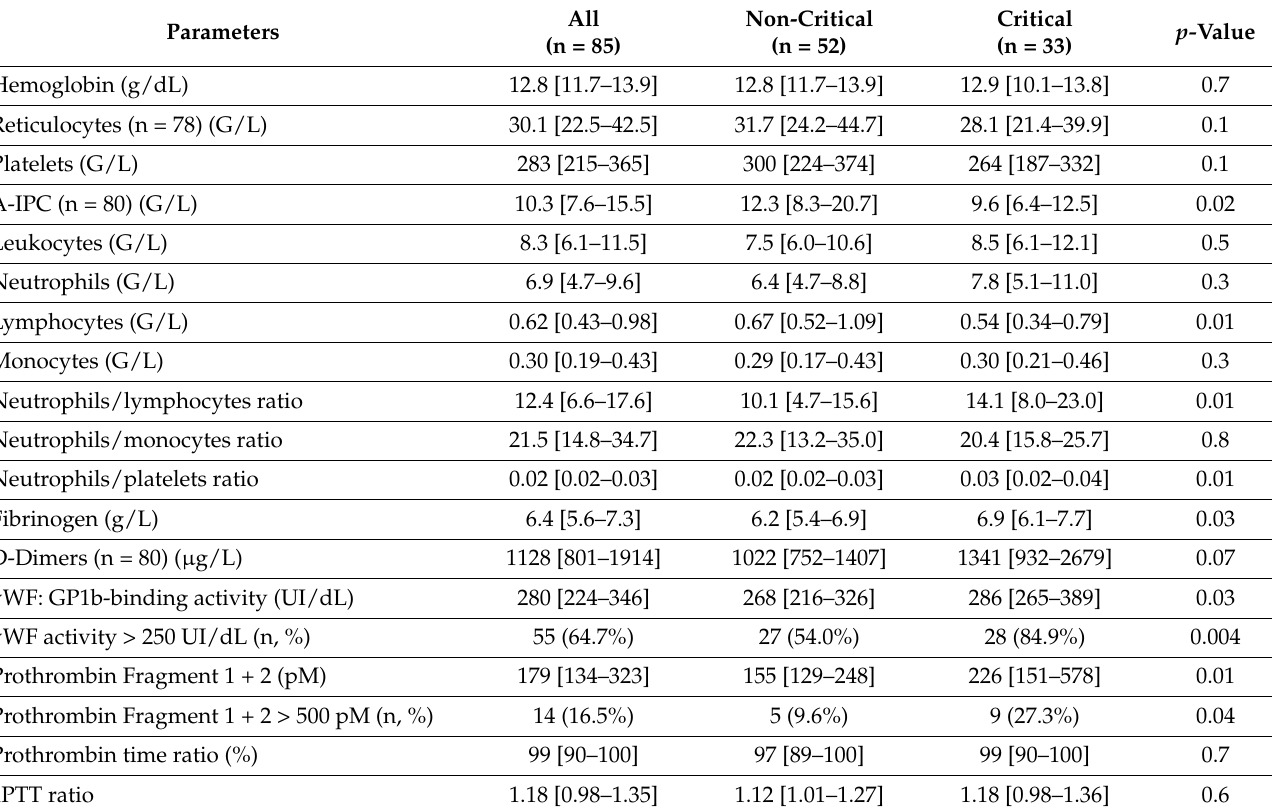
Table 3. Blood count and hemostasis assays at admission in